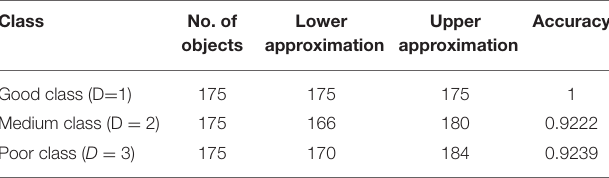
TABLE 4 | Quality approximation of decision classes. TABLE 5 | Minimal covering rules with strength exceeding 10% in Decision =